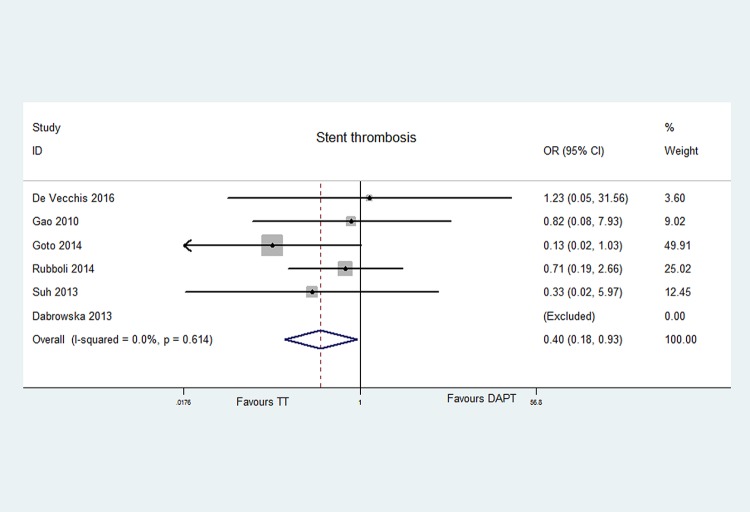
Forest plot of stent thrombosis in patients with TT and DAPT.